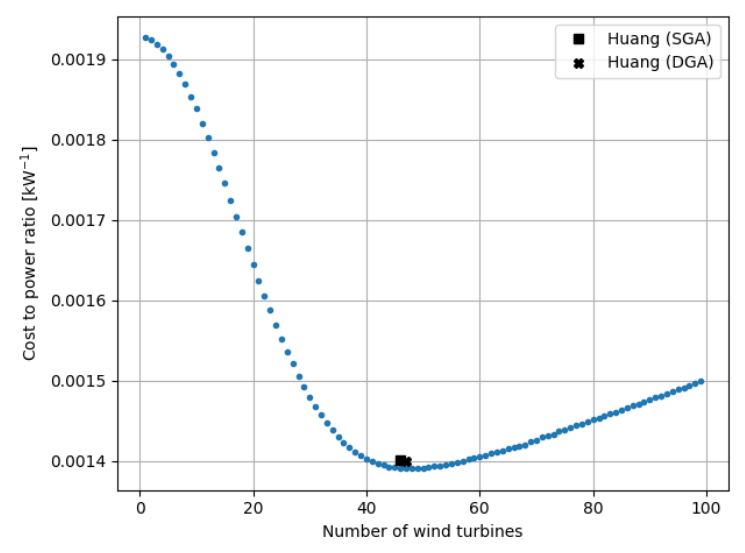
Figure 15. Fitness function values for case 3 for a given number of wind